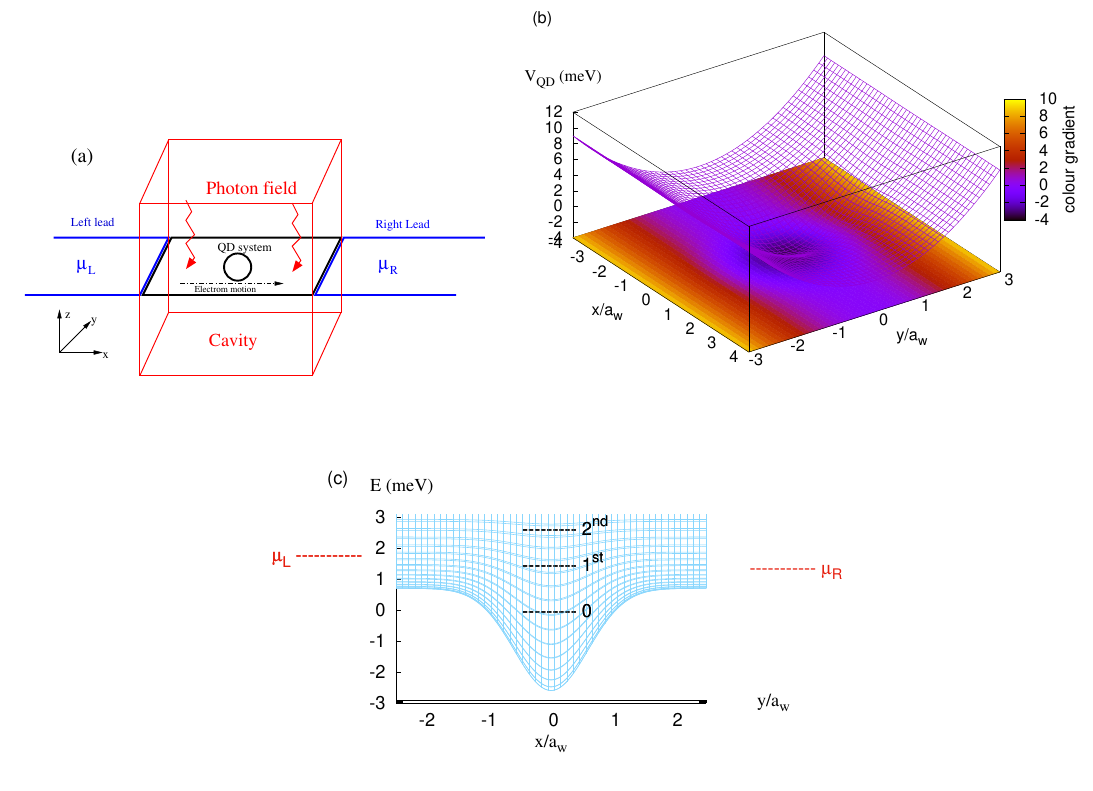
Figure 1. ( a ) Schematic diagram demonstrates the QD system (black) connected to the leads (blue) where the chemical potential of the left lead ( µ L ) is higher than the that of the right lead ( µ R ). The red zigzags indicate the quantized photon field in the cavity (red rectangle). ( b ) The potential V QD defining the QD embedded in a short quantum wire that is connected diametrically to the leads in the x -direction. ( c ) The potential V QD in relation to the chemical potentials of the leads and the three lowest one-electron states of the